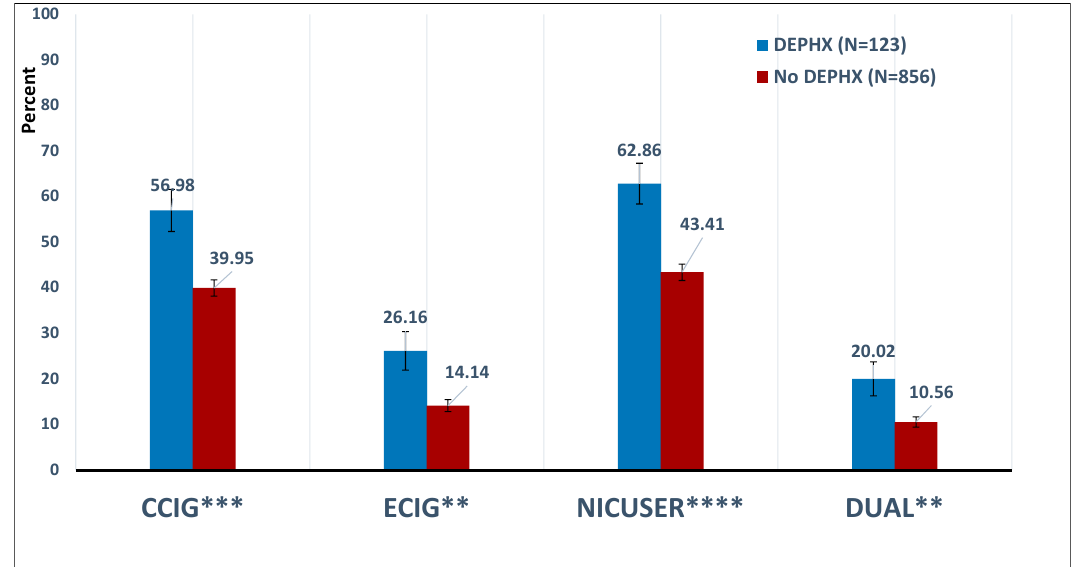
Figure 1. Tobacco Product Use by History of Depression (DEPHX). ** p < 0.01; *** p < 0.001; **** p < 0.0001.